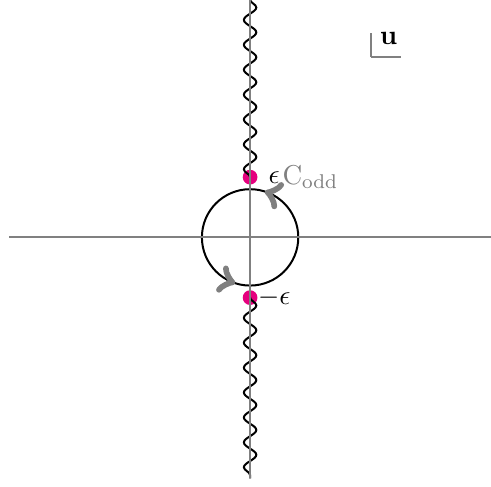
Figure 4 . Contour C odd in the u -plane for even AdS d +1